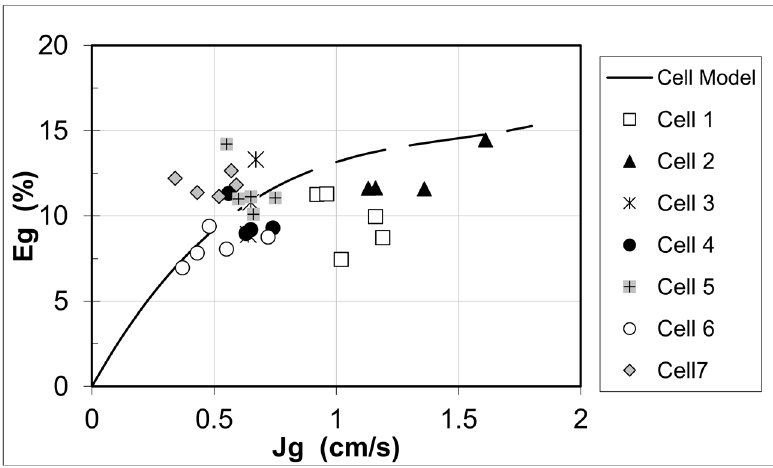
Figure 9. The gas holdup ( ε g ) versus gas rate ( J g ) for Cell 5 and for all seven cells in the bank of OK 130 cells.